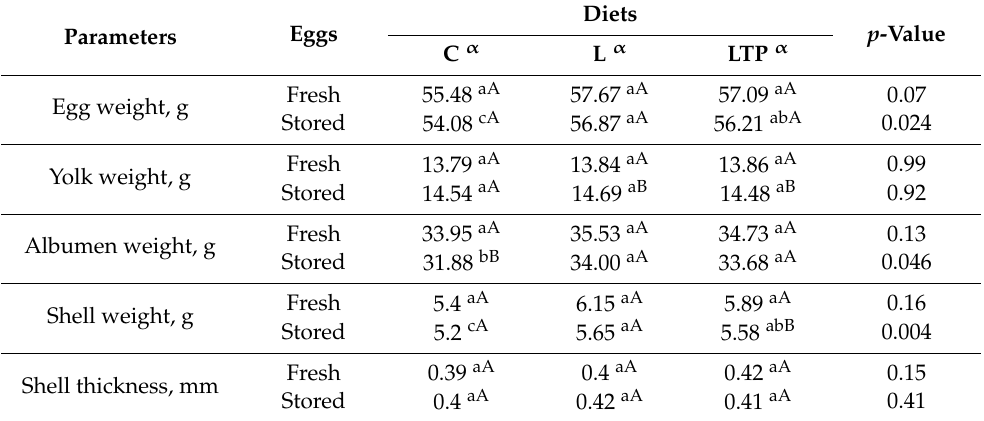
Table 2. Physical characteristics of eggs before and after storage at 4 ◦ C for one